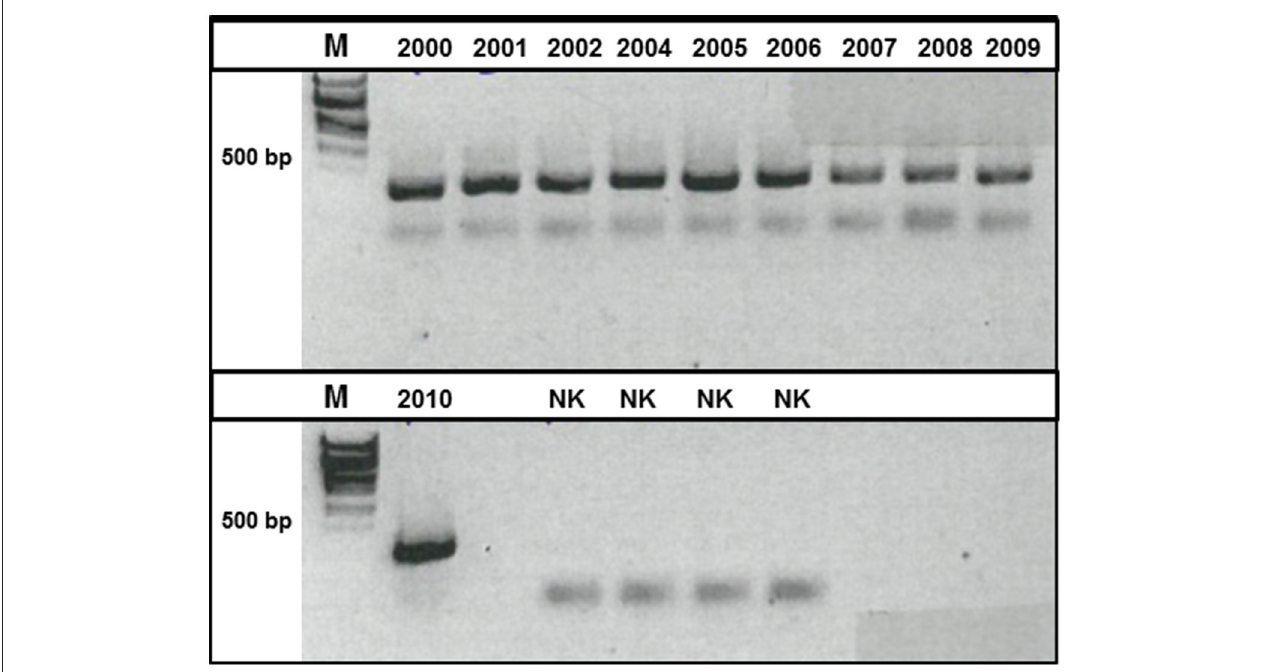
FIGURE 2 | Picture of an agarose gel (1.5% [w/v]) to visualize the outcome of the amplification of a 18S DNA fragment via PCR. The size of the PCR-product was determined in comparison to a 1 kb size marker (M).